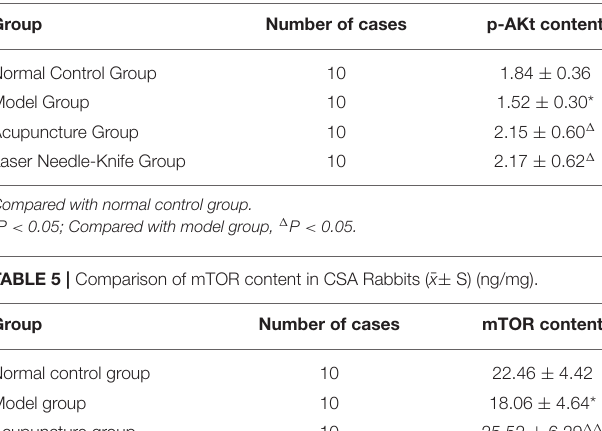
TABLE 7 | Comparison of VEGF content in CSA Rabbits ( ¯ x ± S) (pg/mg).